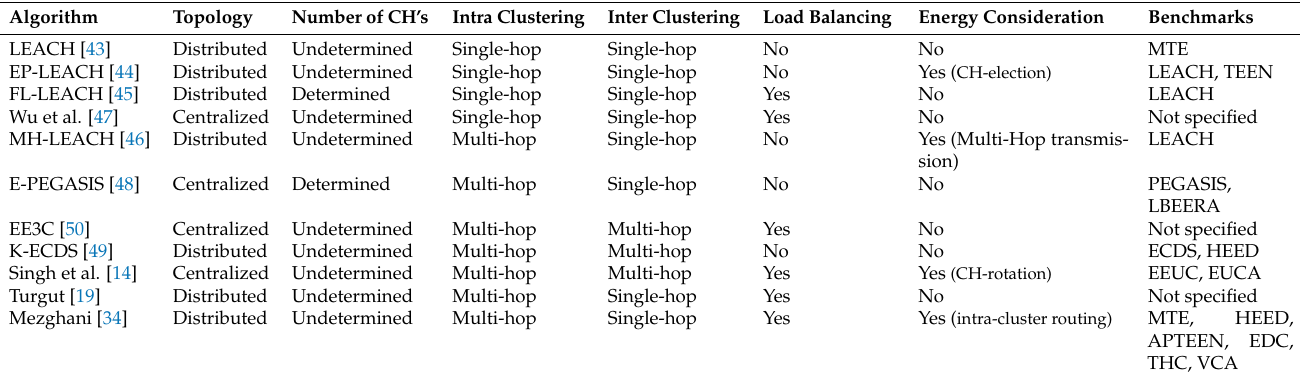
Table 2. Clustering algorithms properties